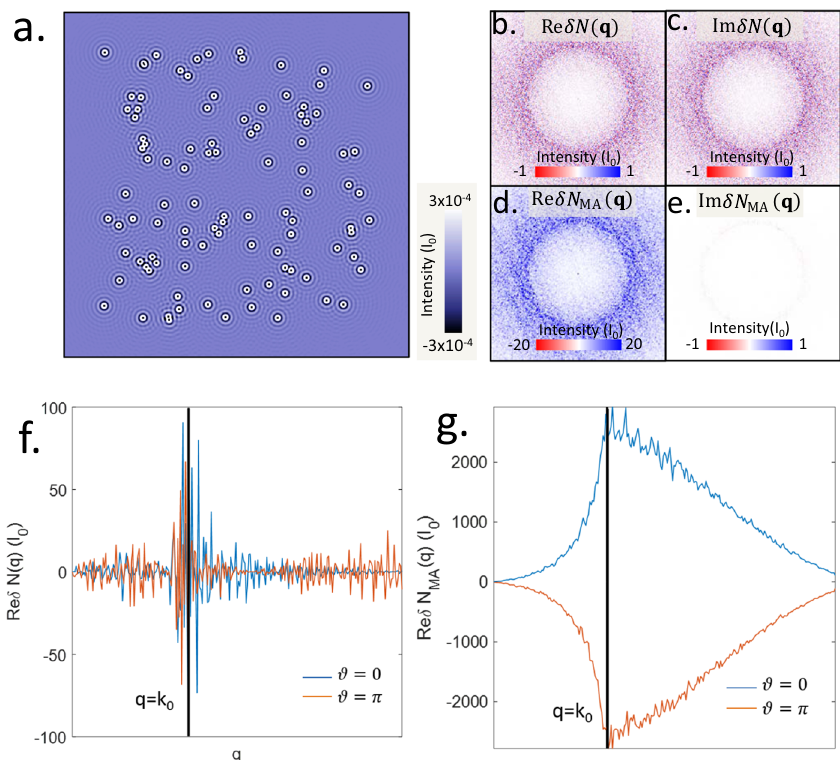
Fig. 1 Schematic for multi-atom phase analysis. a Simulation of density of states perturbation δ N ( r ) in amplitude units I 0 due to two- dimensional Friedel oscillations surrounding 100 impurity atoms at random locations R i . b Real part of Fourier transform Re δ N ( q ) from δ N ( r ) in a . We use an integer grid, hence the units of Fourier transform are also I 0 . c Imaginary part of Fourier transform Re δ N (q) from δ N (r) in a . d Real part of Fourier transform Re δ N MA ( q ) calculated using multi-atom technique of Eq. (7). e Imaginary part of Fourier transform Re δ N MA ( q ) calculated using multi-atom technique of Eq. (7). f Re δ N ( q ) from δ N ( r ) in a for ϑ ¼ 0 and ϑ ¼ π , integrated azimuthally from b . Its strong random fl uctuations versus | q | are due to summing the Friedel oscillations in δ N ( r ) of a with random phases due to the random locations R i . g Re δ N MA ( q ) from δ N ( r ) in a integrated azimuthally from d . Re δ N MA ( q ) is now orders of magnitude more intense than in f , and the phase of the Friedel oscillations in δ N ( r ) of a is now very well de fi ned because the effects of random locations R i are removed by using Eq. (7). Note